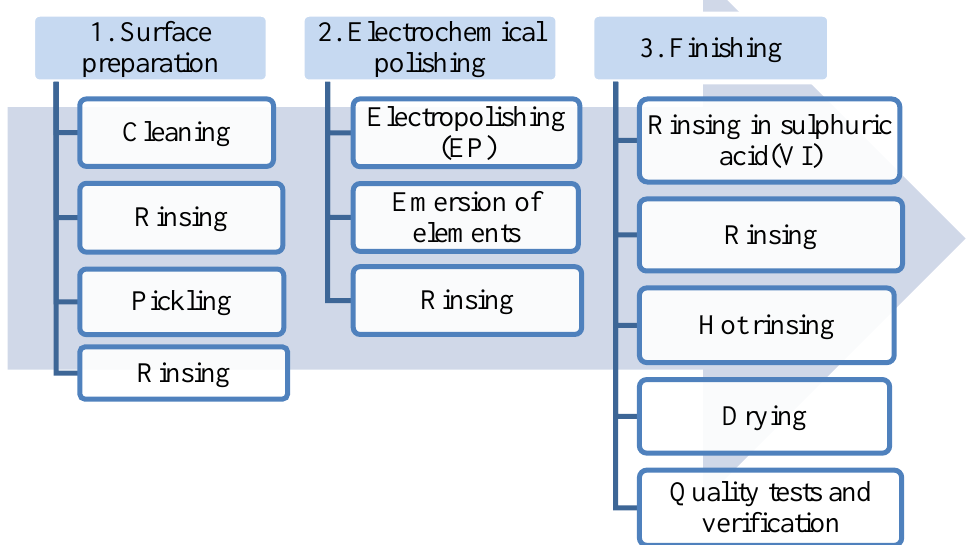
Figure 3. Technological diagram of a typical electrochemical polishing process.